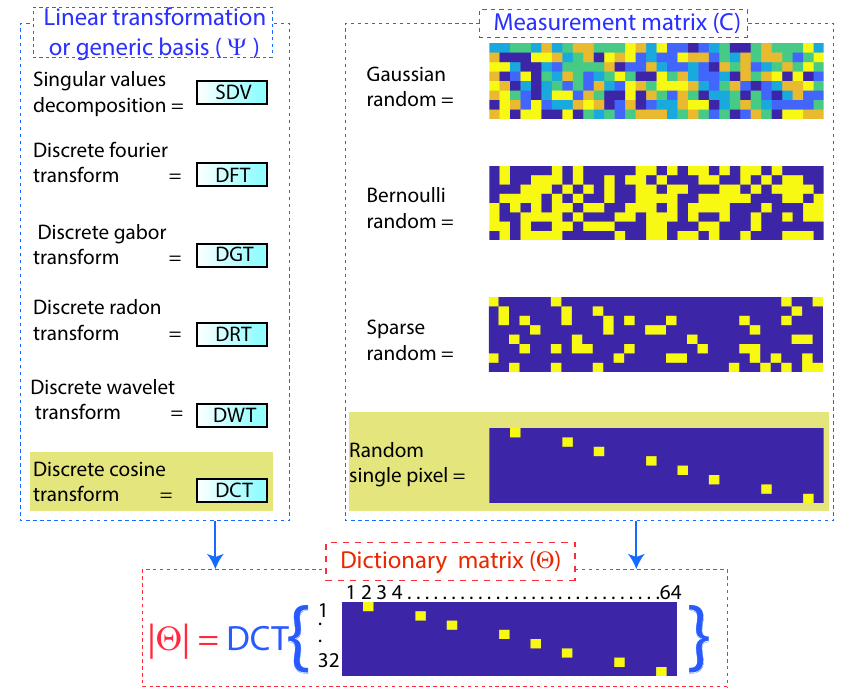
Figure 6. Formation of the dictionary matrix ( Θ